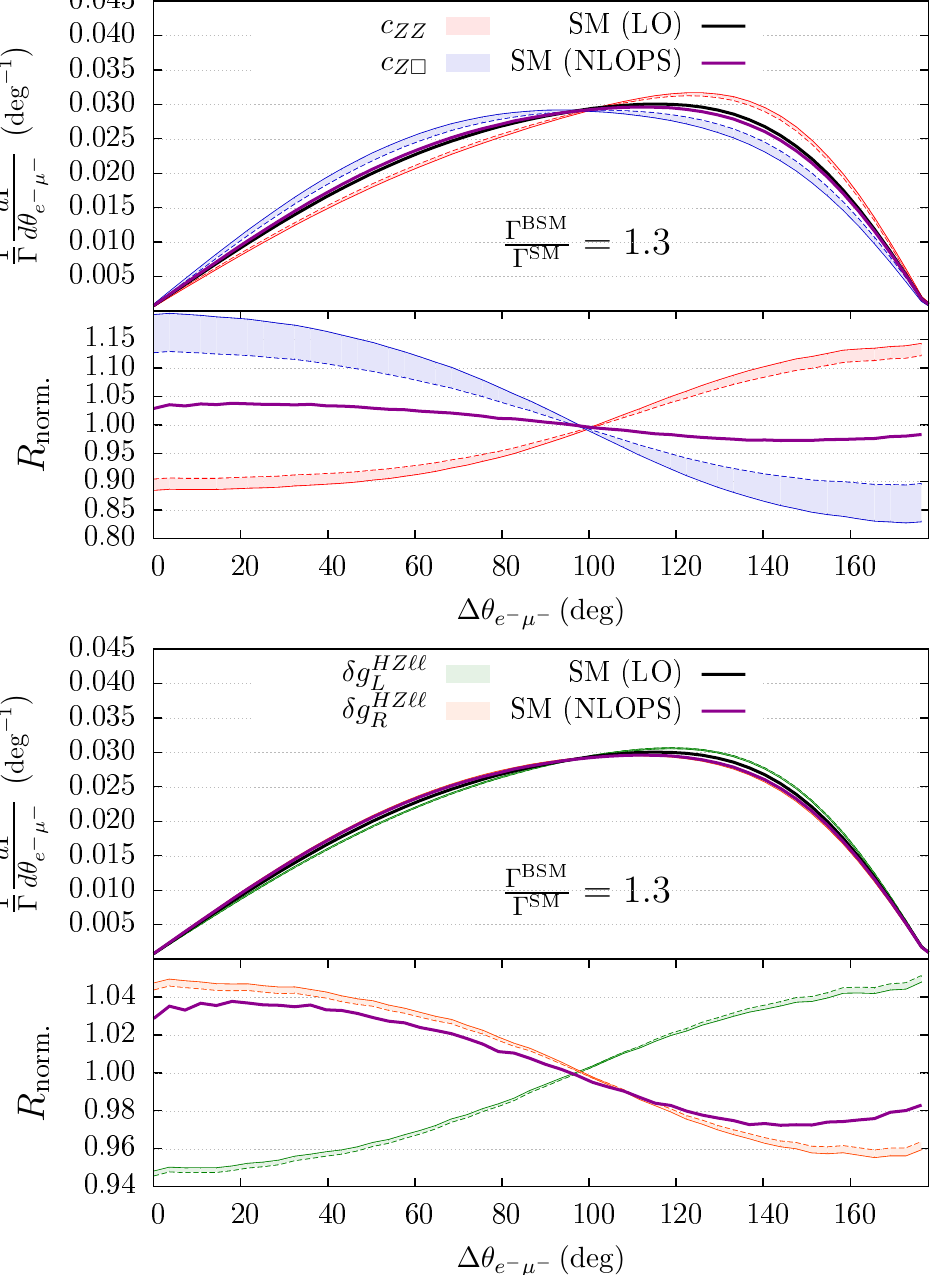
Figure 4. Upper panels: normalized distributions for (cid:1) (cid:18) accuracy (violet curve) and for values of c ZZ (red curves), c Z (cid:3) (blue curves), (cid:14)g HZ‘‘ giving rise to a ratio R BSM = 1 : 3. Lower panels: normalized ratios, according to the de(cid:12)nitions in eq. (4.2). Solid lines refer to pure 1 = (cid:3) 2 e(cid:11)ects, for dashed lines quadratic contributions are also included. The shaded bands between solid and dashed lines highlight the shape variations induced by the inclusion of quadratic terms.